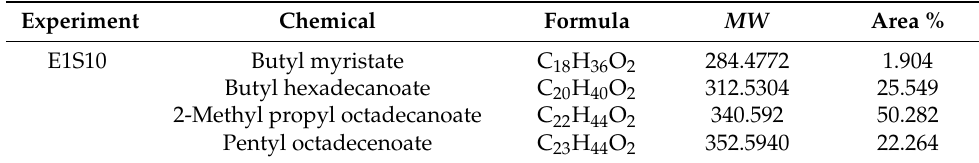
Table 5. FABE profile from beef tallow transesterification using